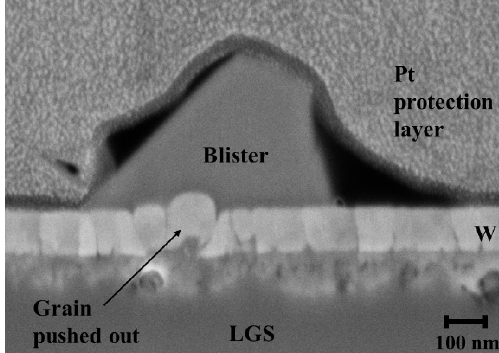
Figure 4. FIB ‐ cut around the blistered area on W ‐ LGS after annealing to 800 °C showing a grain pushed out.